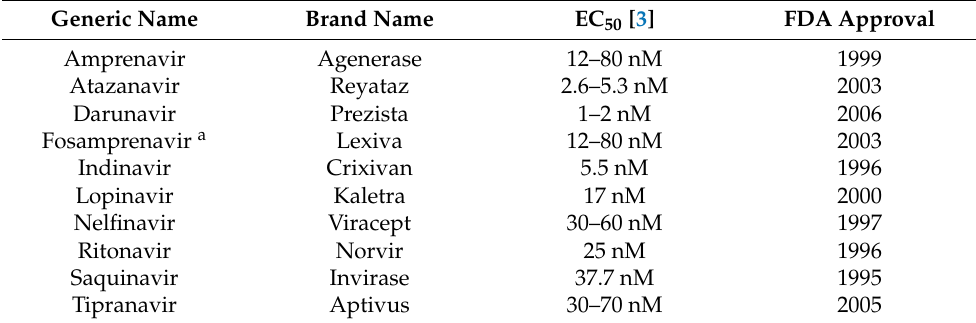
Table 1. FDA-approved HIV-1 protease inhibitors which will be used as a reference for the de novo design of the new chemical compounds. a Fosamprenavir is the phosphate ester prodrug of